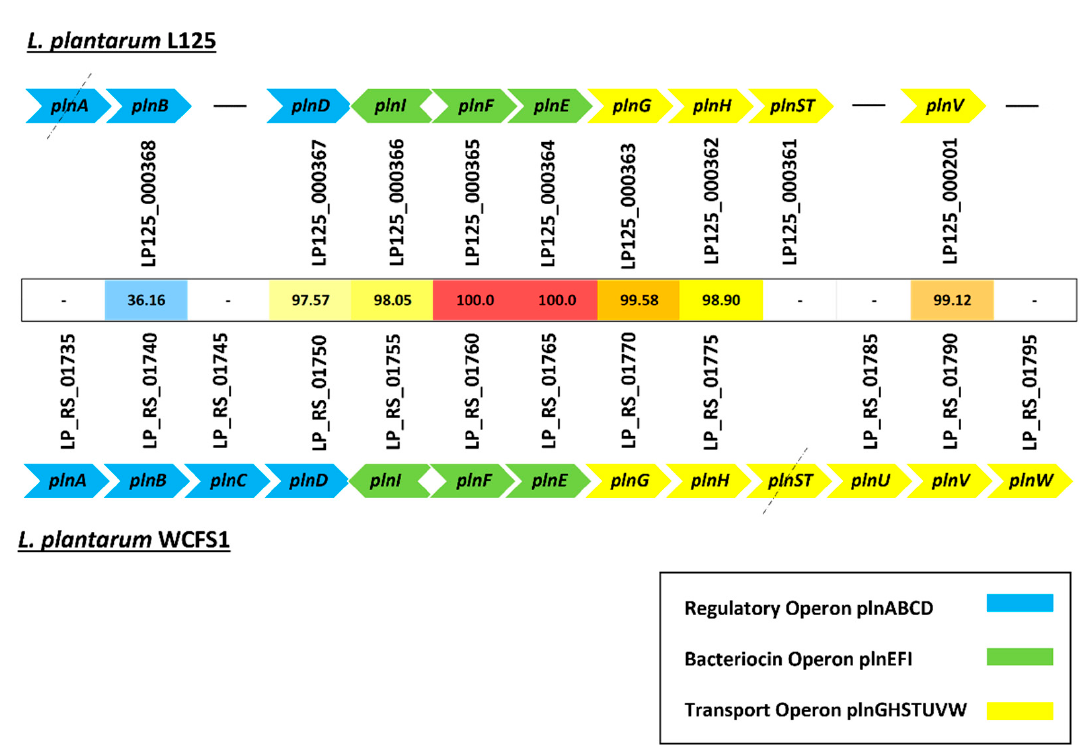
Figure 6. Detailed comparison of genes inside the pln locus ( plnABCD , plnEFI and plnGHSTUVW operons) between L. plantarum L125 and L. plantarum WCFCS1. Black dashed lines represent pseudogenes, while black hyphens indicate gene absence. Protein identities are also indicated.